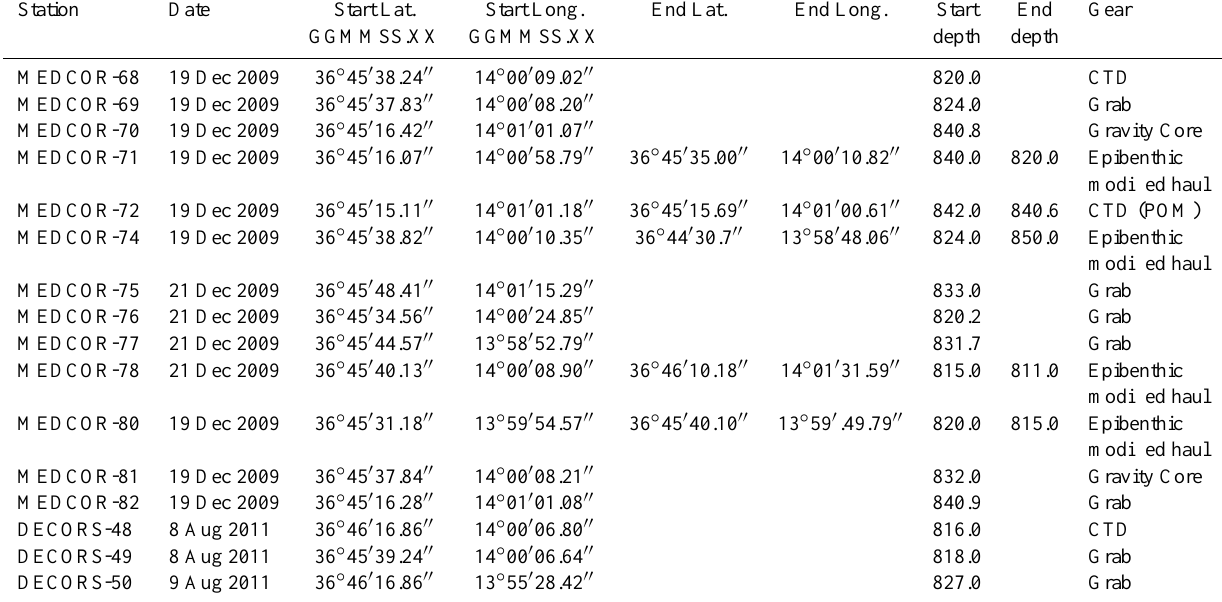
Table 1. Sampling station list of Cruises MEDCOR and DECORS in the Gela Basin. Station Date Start Lat. Start Long. End Lat. End Long. GGMMSS.XX